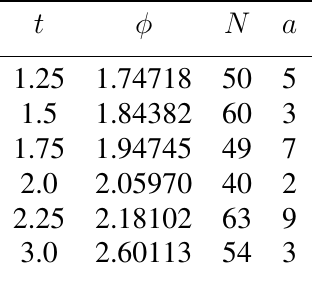
Table 1: High-precision benchmark values of the scalar flux for the example problem at x = 1 and various times. For each time, the value of N required to obtain the specified precision as well as the value of a used are also